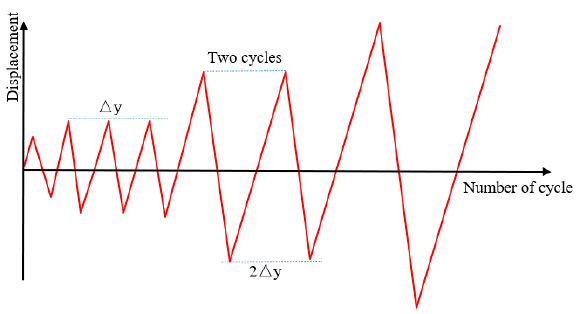
Figure 4. Loading details.